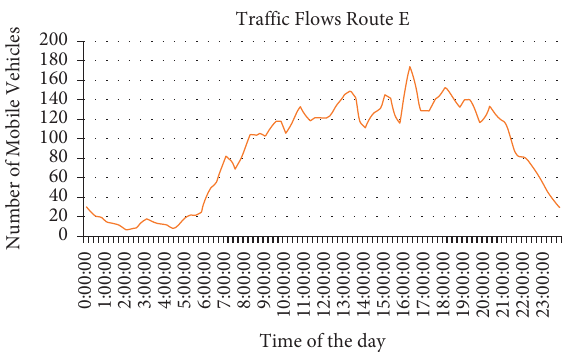
Figure 8: Traffic flow: route A.